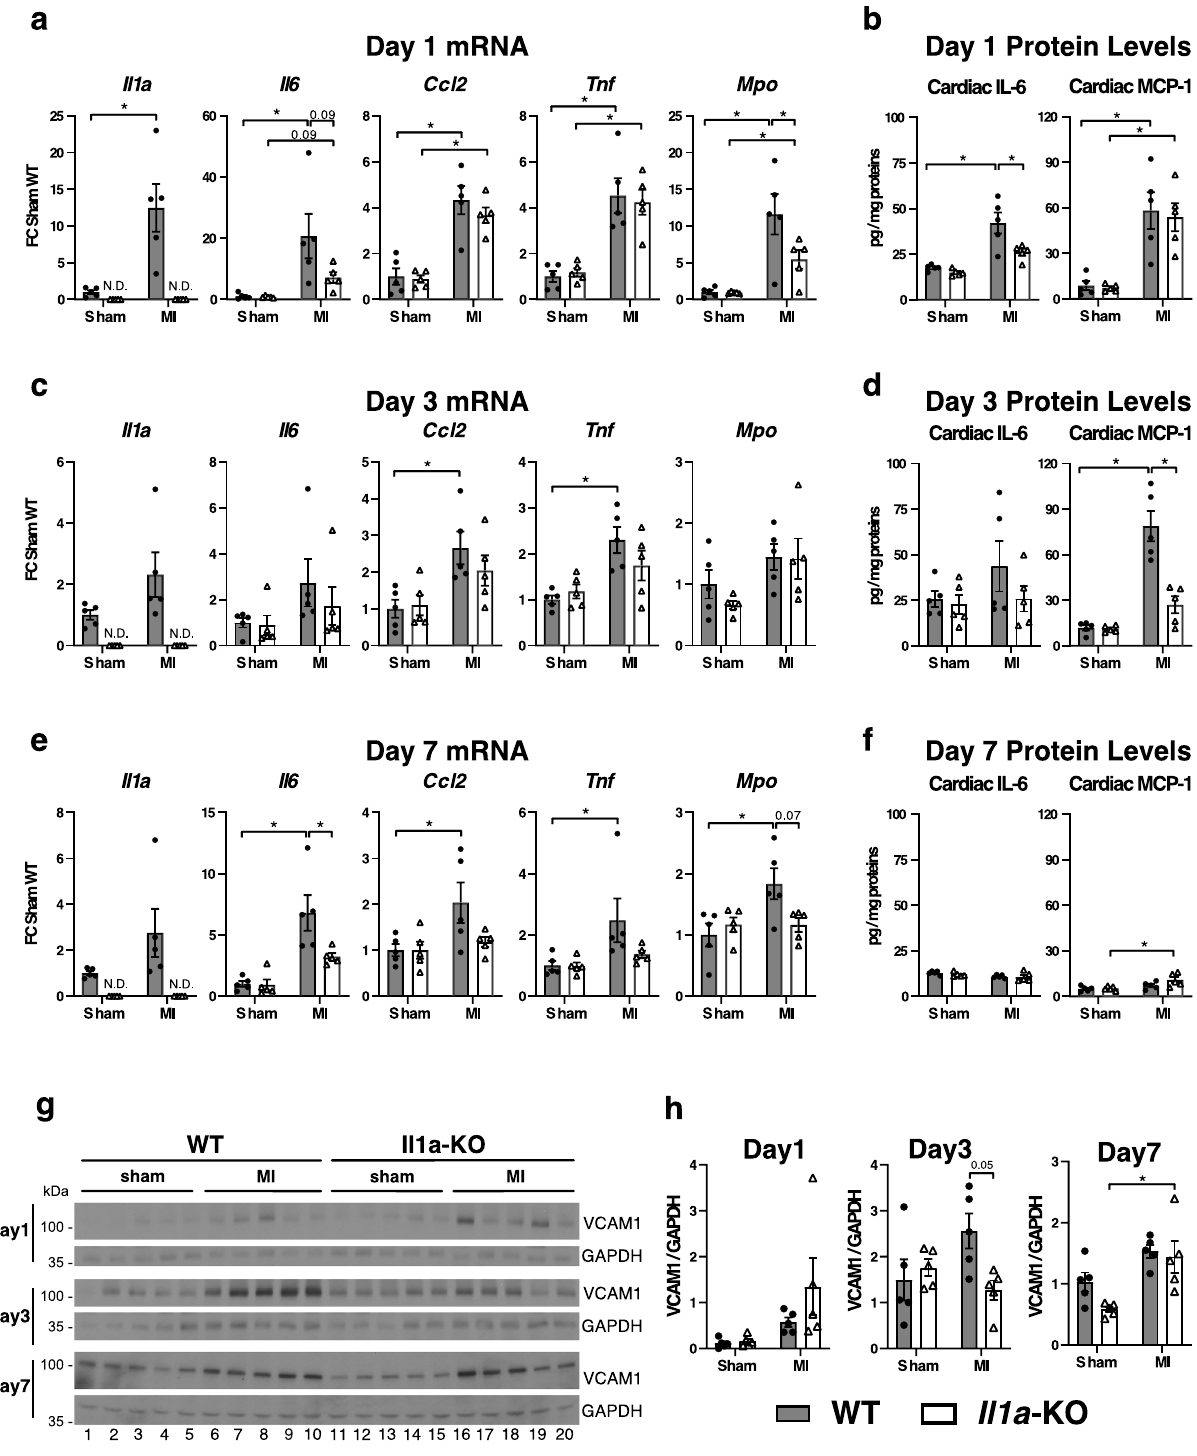
Figure 1. IL-1α-deficiency decreases myocardial inflammation after myocardial infarction. WT and KO mice subjected to chronic LAD ligation (myocardial infarction, MI) or sham surgery were sacrificed after 1, 3 or 7 days and the heart obtained for mRNA, ELISAs and western blot analyses. ( a ) Myocardial mRNA expressions of Il1a , Il6 , Ccl2/Mcp1 , Tnf and Mpo pro-inflammatory genes and ( b ) myocardial IL-6 and MCP-1 protein levels at day 1 post sham or MI surgery. ( c ) Myocardial mRNA expressions of Il1a , Il6 , Ccl2/Mcp1 , Tnf and Mpo pro-inflammatory genes and ( d ) myocardial IL-6 and MCP-1 protein levels at day 3 post sham and MI surgery. ( e ) Myocardial mRNA expressions of Il1a , Il6 , Ccl2/Mcp1 , Tnf and Mpo pro-inflammatory genes and ( f ) myocardial IL-6 and MCP-1 protein levels at day 7 post sham and MI surgery. The mRNA expressions of target genes were detected by RT-PCR, normalized to Rps18 housekeeping gene expression and expressed as fold change (FC) over sham WT. Cardiac IL-6 and MCP-1 protein expression levels were analyzed by ELISA on tissue lysates and expressed as pg/mg of total proteins. ( g ) Myocardial expression of VCAM-1 detected by western blot 1, 3 and 7 days after sham or MI surgery. GAPDH shown as loading control. ( h ) Quantifications of images shown in g expressed as VCAM-1/GAPDH ratios. For all data, MI and sham surgery, N = 5/group. * p < 0.05. N.D., not